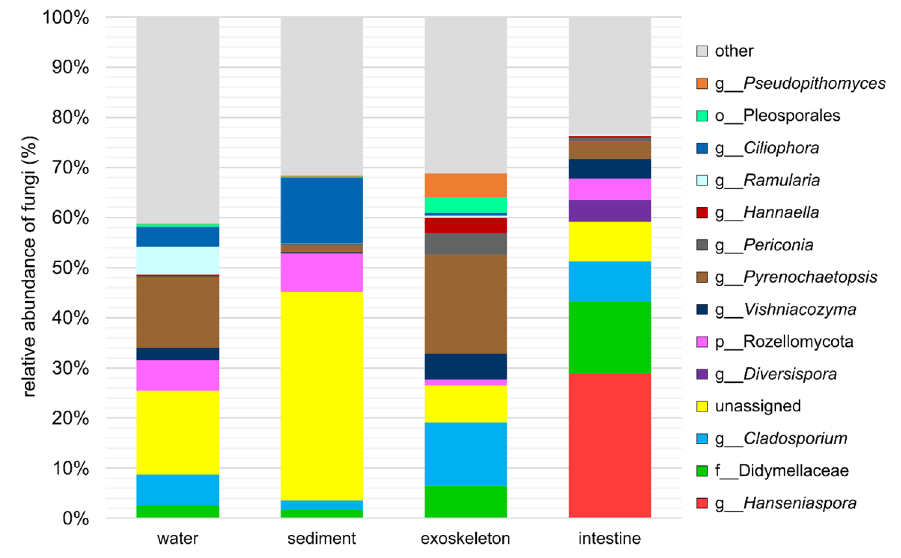
Fig. 3 Relative abundance (%) of the overall most prevalent genera of all four sample groups. ASVs that could not be identified to genus (g) level are marked with the letter corresponding to the last known taxonomic level (p = phylum, o = order, f = family). Fungal taxa with a total abundance of > 3% are shown, while the remaining taxa were pooled and marked as “other.” ASVs to which taxonomy could not be assigned were pooled and marked as